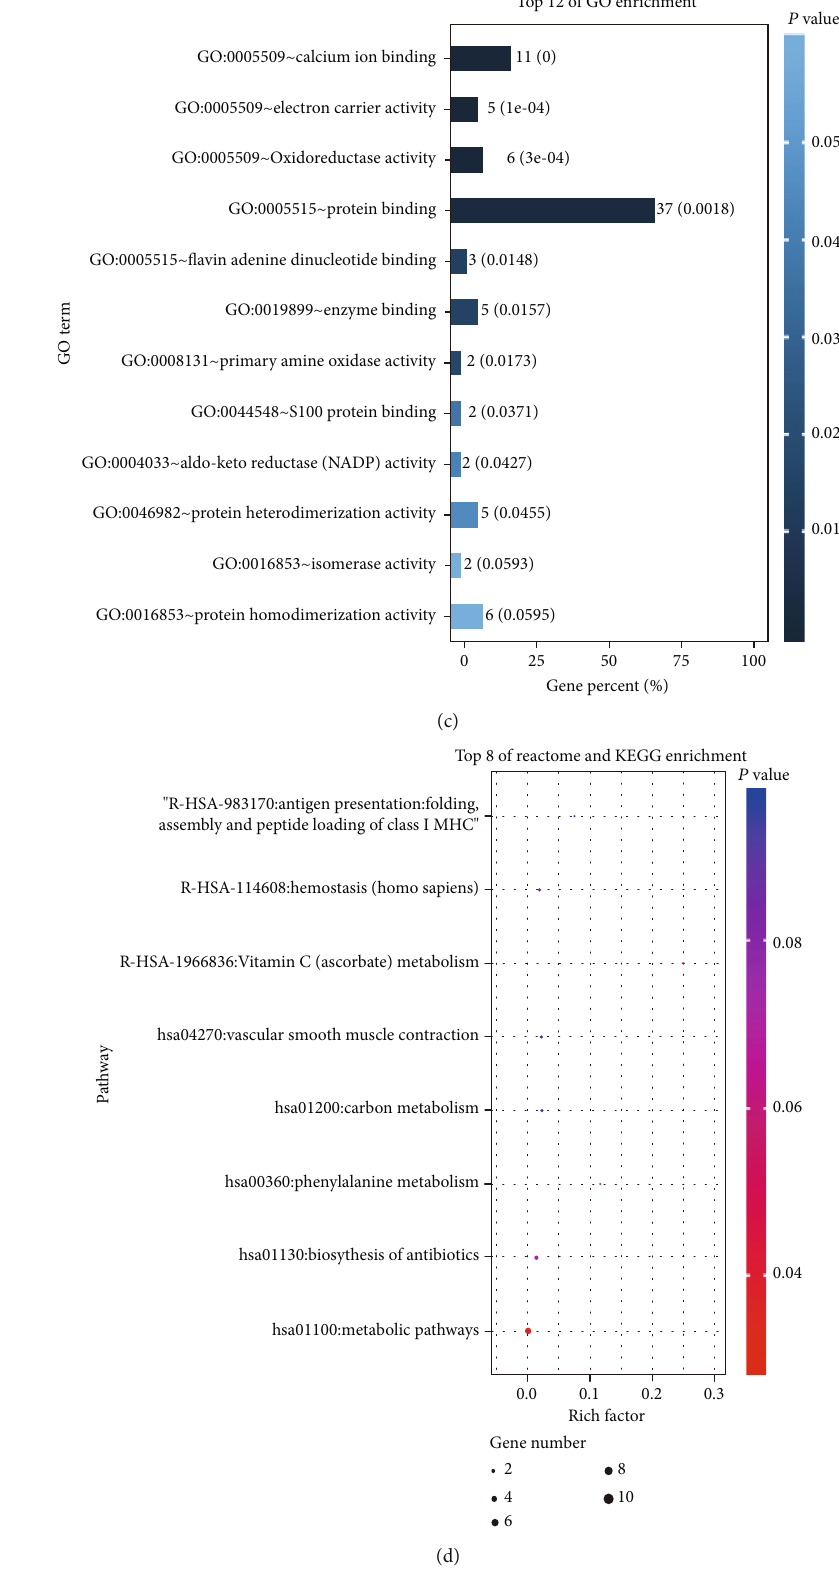
Figure 3: Gene Ontology (GO) and pathway enrichment analysis: (a) biological process; (b) cell composition analysis; (c) molecular function; (d) Reactome and Kyoto Encyclopedia of Genes and Genomes (KEGG) pathway enrichment